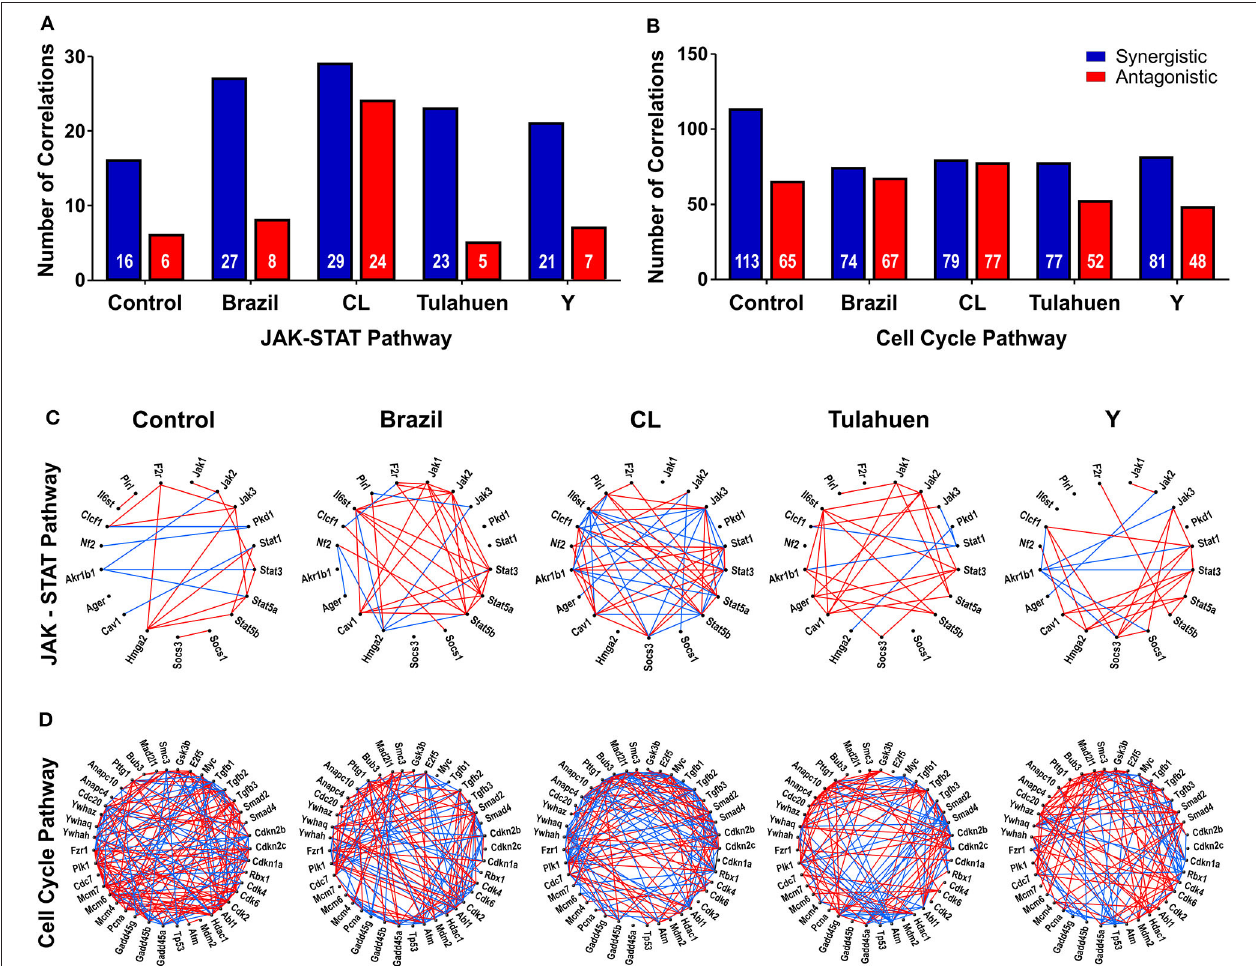
FIGURE 4 | Trypanosoma cruzi infection affects the coordination of genes belonging to JAK/STAT and cell cycle pathways. The number of synergisms (blue bars) and antagonisms (red bars) for the JAK/STAT (A) and Cell Cycle (B) pathways are shown, as determined by Pearson correlation analysis. The circles in (C,D) depict the synergistic (blue lines) and antagonistic (red lines) correlations between genes of each pathway, in uninfected and T. cruzi -infected datasets.